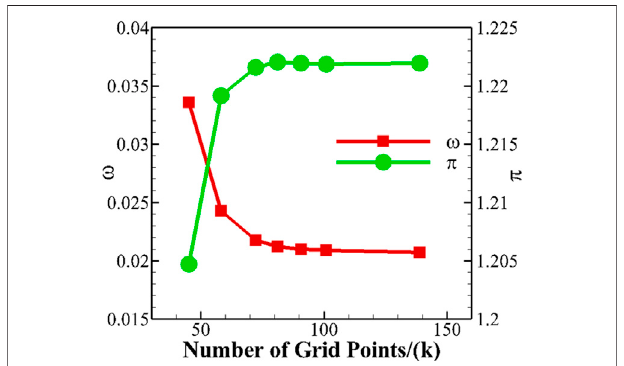
FIGURE 5 | Effect of grid points number on the loss and static preesure ratio.